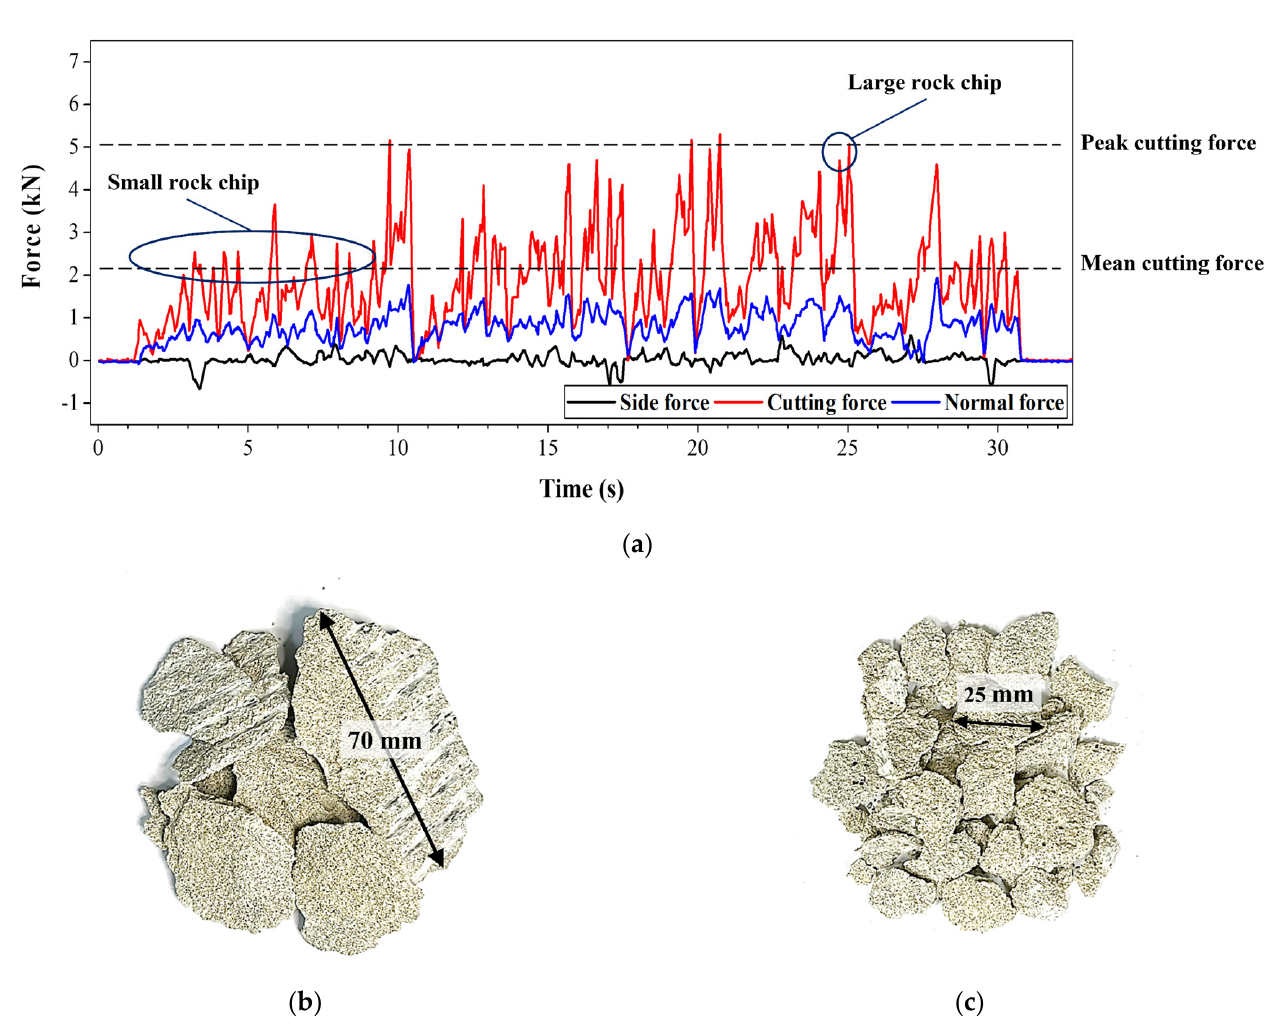
Figure 6. Cutting forces and rock chips generated during the experiment: ( a ) cutting forces during the generation of rock chips, ( b ) large rock chips, and ( c ) small rock chips.